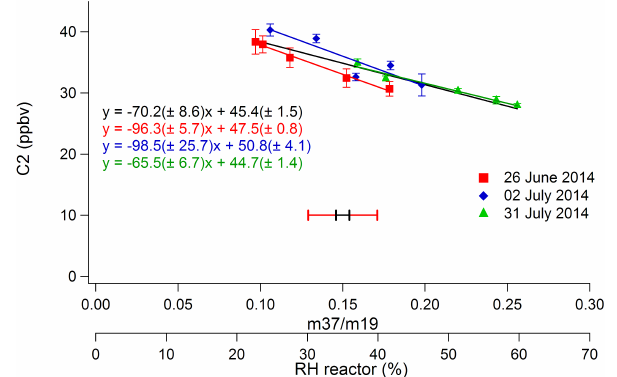
Figure 2. Changes in C2 due to changes in RH. RH is tracked using the m 37 /m 19 ratio monitored by PTR-ToFMS. The correspond- ing RH measured in the CRM reactor at 22 ◦ C is given on a sec- ond x axis. Three experiments conducted during the Dunkirk field campaign are shown. The solid black line is a linear regression for the three experiments. Red, blue, and green lines are linear regres- sions for individual experiments made on 26 June, 2 July, and 31 July, respectively. Error bars are the measurement precision (1 σ) . Black and red intervals are the mean and the maximum variations of m 37 /m 19 observed between C2 and C3 during the Dunkirk cam- paign,